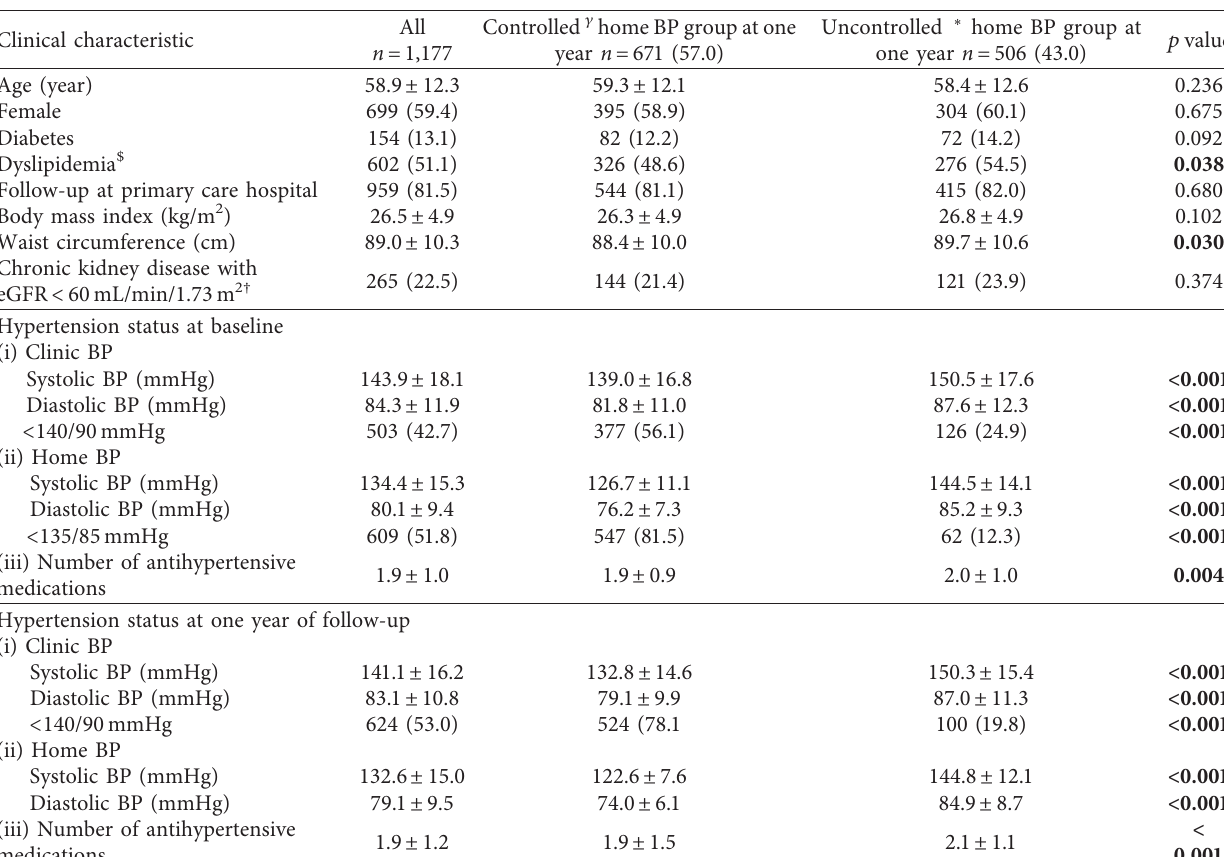
Table 1: Demographics and patient characteristics.